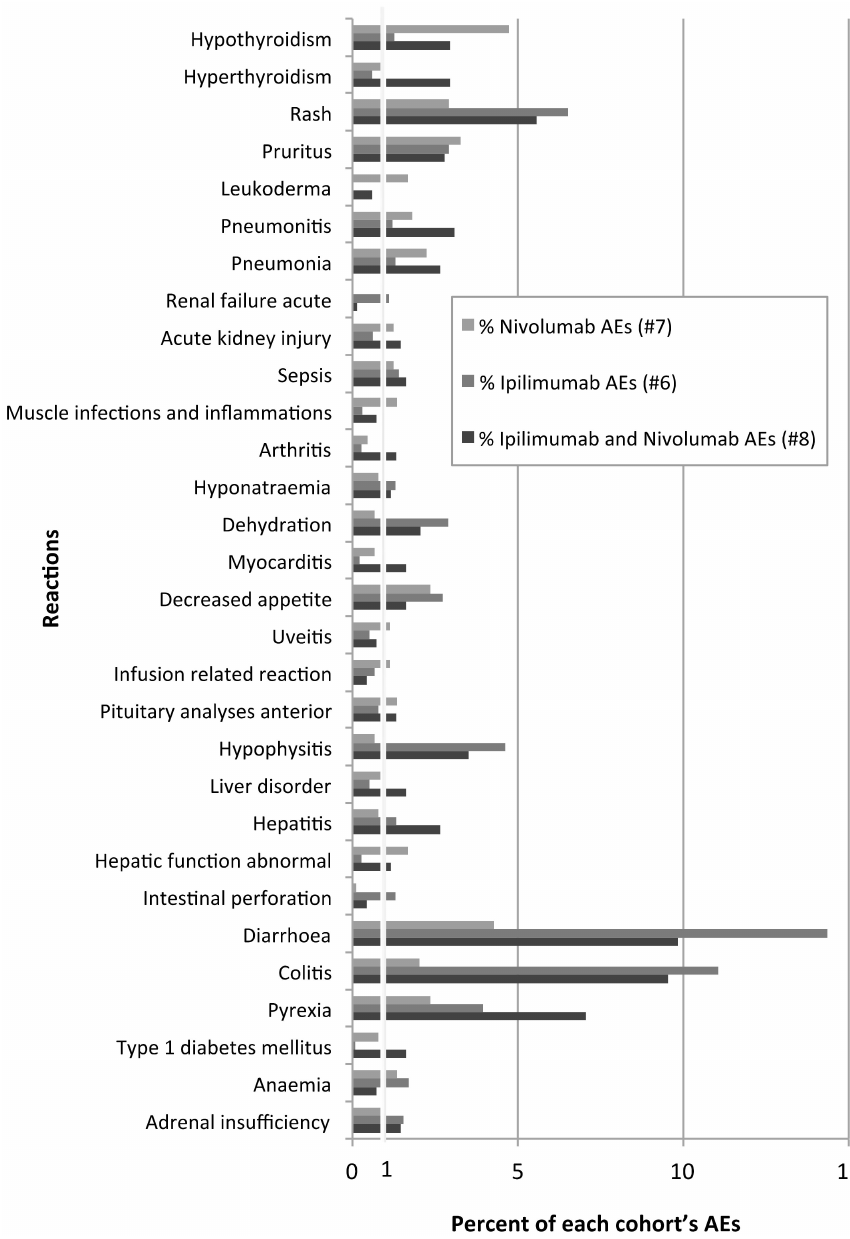
Figure 3. The safety profiles of ipilimumab, nivolumab and their combination. The table ( upper ) lists the identified reactions organized by affected organ/system. For the selection, statistical significance ( p -value < 0.05), PRR signal > 1, and occurrence in at least 1% of a cohort’s AEs ( lower ) were required. While some reactions were specific to one set, many were reported in all three, but with different signals. For example, ‘Hypophysitis’ was reported in 125 AEs of the ipilimumab cohort and in 24 AEs of the ipilimumab plus nivolumab cohort—when, in comparison, overall it was mentioned in a total of 475 AEs in FAERS—thus rendering it the reaction with the highest PRR signal for these cohorts (PRR#6: 1051; PRR#8: 621). Similarly, ‘Leukoderma’ had the strongest PRR signal among nivolumab reactions (PRR#7: 2439), reported in fifteen AEs of this cohort, when there were only seventy AEs in FAERS mentioning it altogether. Similarly, ‘Myocarditis’ (with 2713 AEs in FAERS) was reported in eleven AEs of the ipilimumab plus nivolumab combination cohort (PRR#8: 47.5), and ‘Colitis’ (with 12513 AEs in FAERS) was reported in 299, eighteen, and 65 AEs of the ipilimumab, nivolumab, and the ipilimumab plus nivolumab cohorts (PRR#6: 72; PRR#7: 12.9; PRR#8: 61),